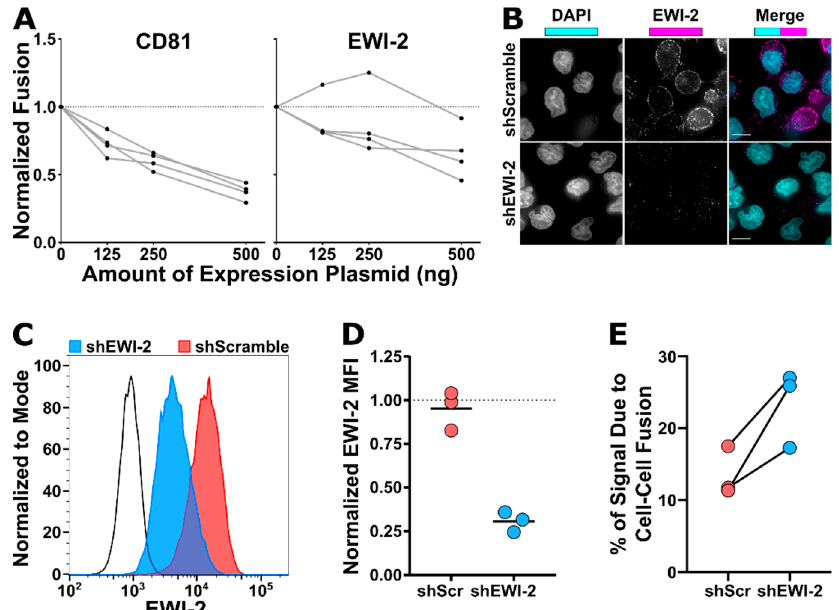
Figure 5. EWI-2 inhibits infected-uninfected cell fusion . ( A ) HeLa-TZM-bl fusion assays were performed using producer HeLa cells that were co-transfected with either pNL-sfGI Δ Env ( Δ Env) or pNL-sfGI (WT) in combination with overexpression plasmid totaling 500 ng (using the indicated amount of CD81 or EWI-2 supplemented with L6). Luminescence readings (across 4 independent biological replicates, each with two technical replicates) were divided by the Δ Env condition to obtain the fold increase in fusion, and then normalized to the WT co-transfected with only L6 (i.e., 0 ng of CD81 or EWI-2) condition, making it have a value of 1. Deviation from the dashed line at 1 thus indicates an effect on fusion. Values from the same biological replicate are linked by a grey line. ( B – D ) EWI-2 expression in shScramble (shScr) and shEWI-2 CEM-SS cells was analyzed by microscopy ( B ) and flow cytometry ( C – D ). ( B ) For microscopy, cells were plated onto poly-L-lysine-coated glass, fixed, permeabilized, labeled for EWI-2, and stained using fluorescent secondary antibody (magenta) and DAPI (cyan). Scale bars = 10 μ m. ( C – D ) For flow cytometry analysis, cells were labeled with Live/Dead Fixable Near-IR, fixed, permeabilized, labeled for EWI-2, and stained with fluorescent secondary antibody. (C) Representative histogram of the EWI-2 signal intensity normalized to mode in live cells for unstained controls (black line), shEWI-2 (blue), and shScr (red) cells. ( D ) EWI-2 MFI in live shScr (red) and shEWI-2 (blue) cells from three independent biological replicates, normalized to EWI-2-labeled parental CEM-SS cells (represented at a value of 1 with a dashed line). ( E ) CEM-luc fusion assays were performed using shScr or shEWI-2 producer cells infected with NL4-3, which were co-cultured with CEM-luc target cells in the presence of DMSO (vehicle control, luciferase signal from transmission and cell–cell fusion) or EFV (luciferase signal resulting exclusively from cell–cell fusion). Luminescence readings (across three independent biological replicates) from the EFV-treated condition were divided by the DMSO reading from the same producer cell type and multiplied by 100 to determine the percentage of luciferase expression dependent on cell–cell fusion (syncytium formation) between either shScr or shEWI-2 producer and CEM-luc target cells. Values from the same biological replicate are linked by a black